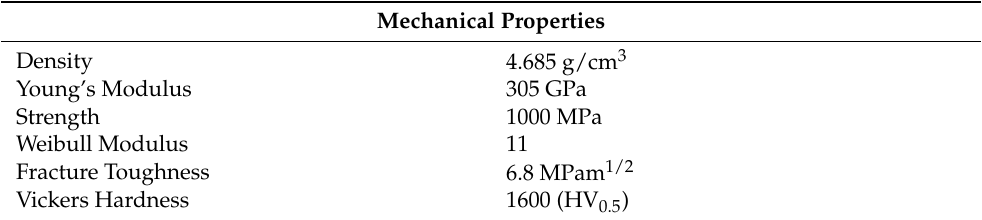
Table 4. Mechanical properties of a composition based on an alumina matrix, containing platelets and about 40 wt-% of zirconia, partially stabilized by yttria and ceria.